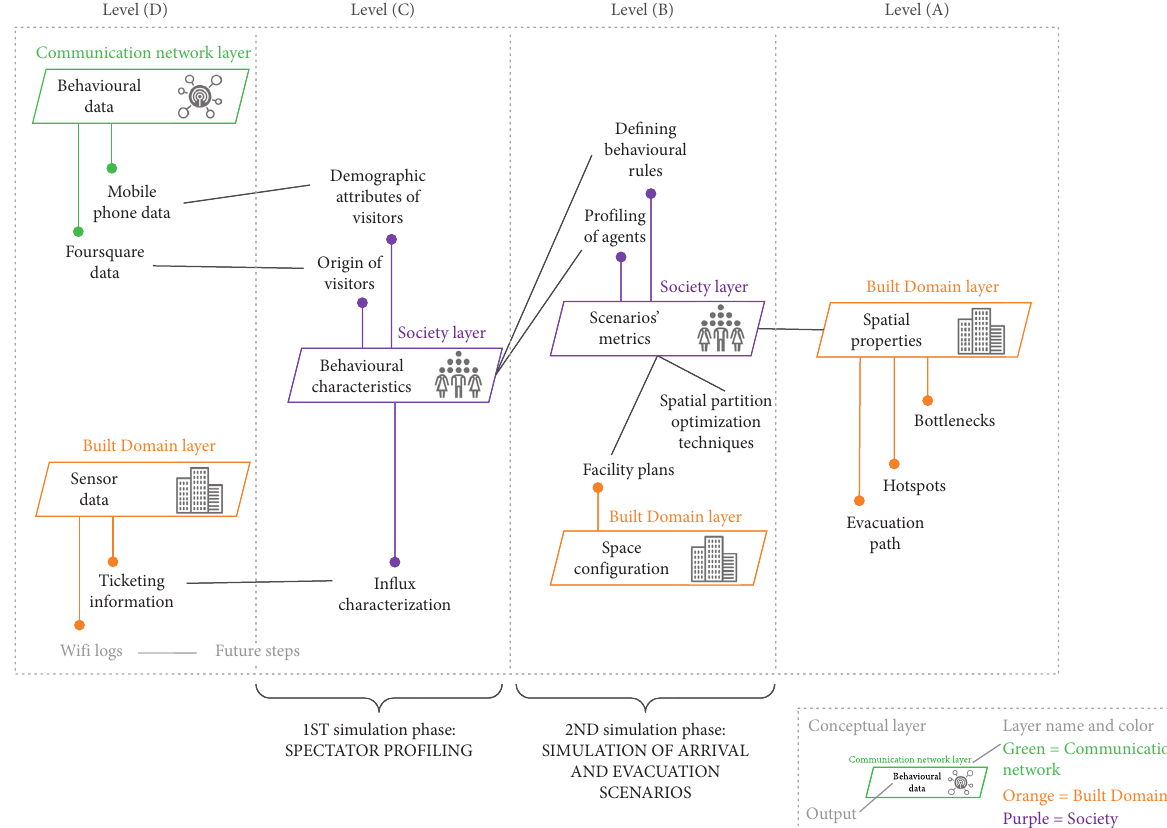
Figure 3: The simulation, layer by layer. The figure shows how conceptual layers interact through simulations. Levels A-B-C-D refer to Figure 2. Created using icons from the Noun Project (https://thenounproject.com, “environment” icon by iconixar, “ecosystem” icon by Kamin Ginkaew, “buildings” icon by Ralf Schmitzer, “Society” icon by David Garc´ıa, “Water” icon by Icongeek26, “Tram” icon by Andrejs Kirma, and “Network” icon by Priyanka) under a CC